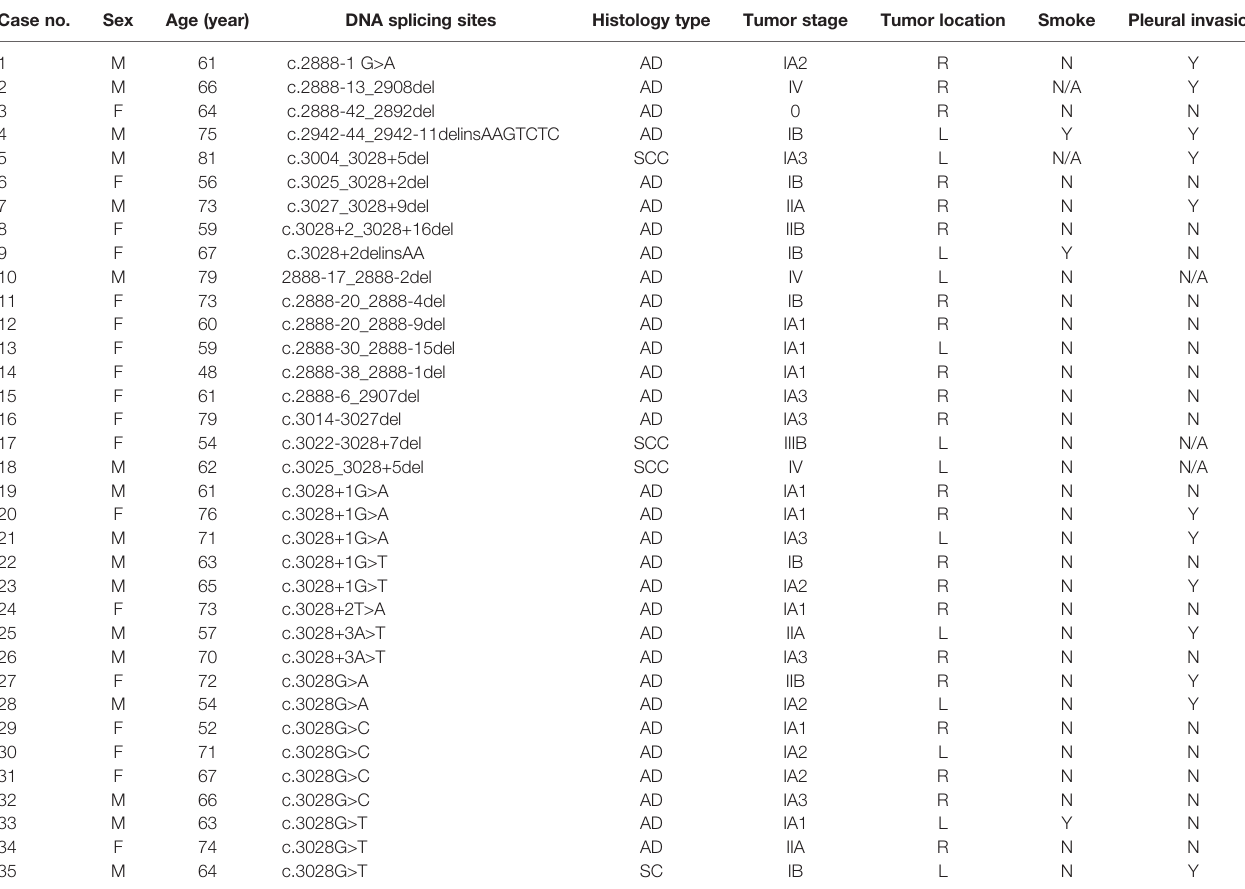
TABLE 5 | DNA splicing sites and clinical information of patients with the MET exon 14 skipping mutation. Case